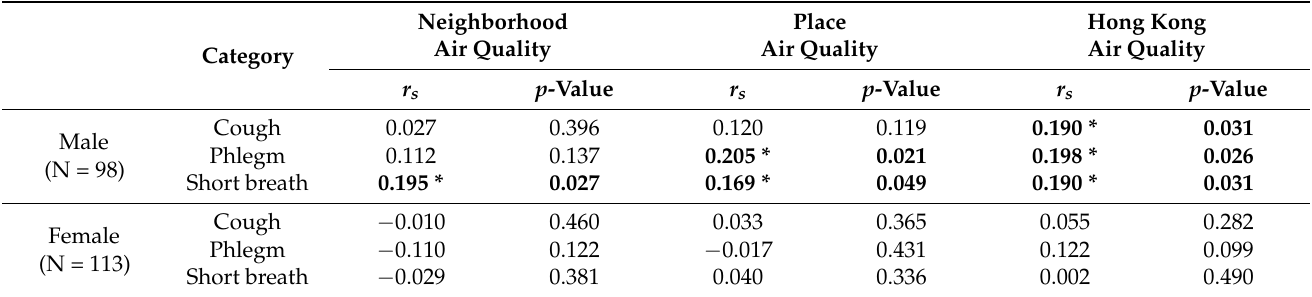
Table 5. The Spearman rank correlation coefficients in the categories of